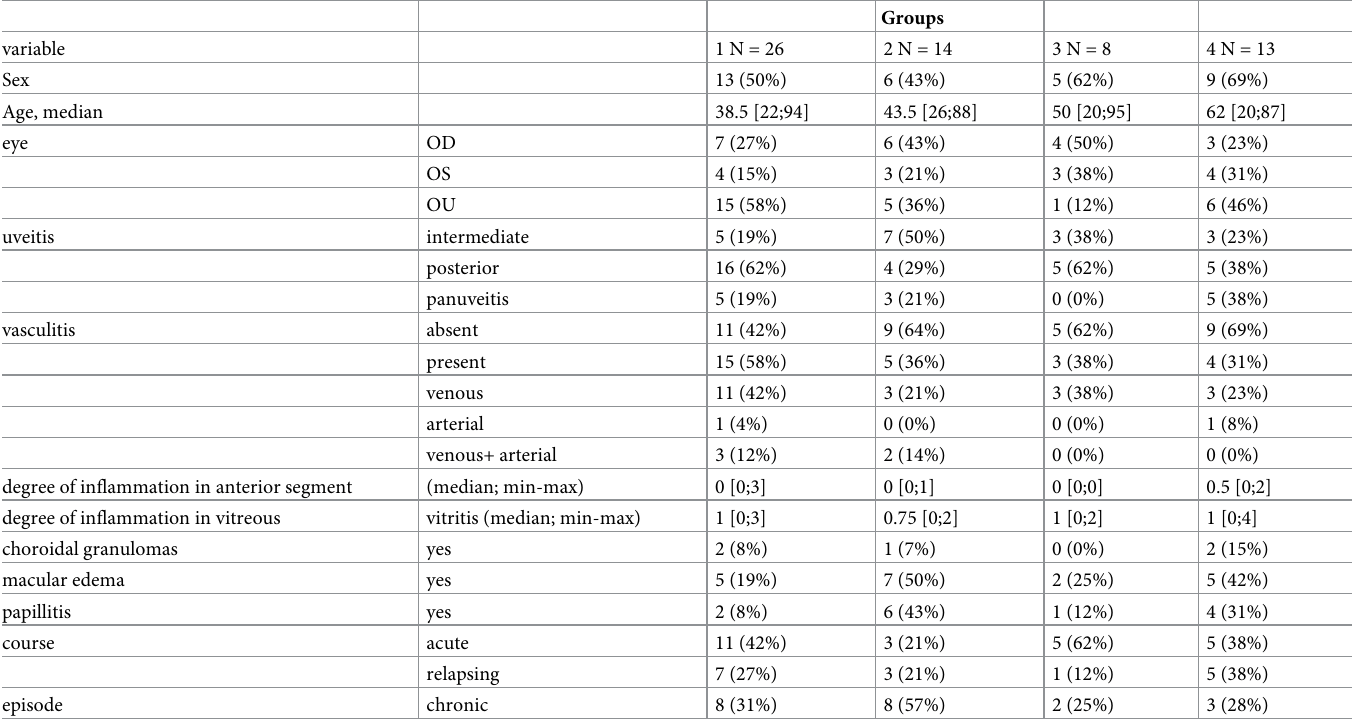
Table 3. Comparison between 4 sub-groups patients with idiopathic uveitis ( n = 64 � ) and their clinical parameters.